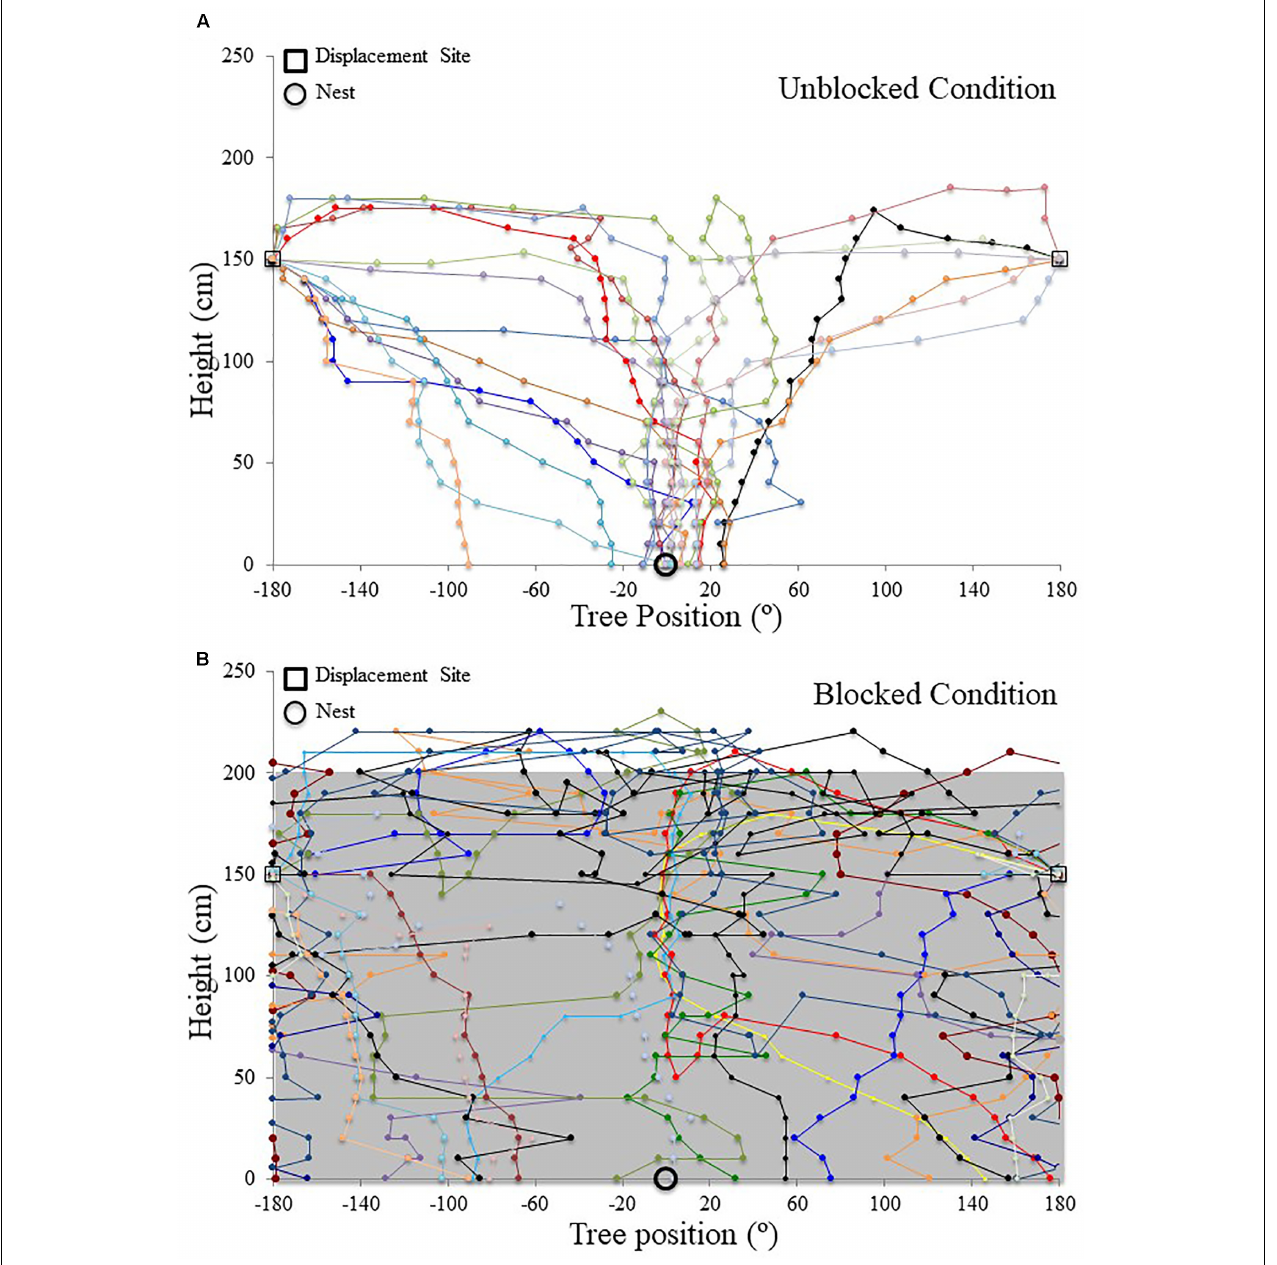
FIGURE 5 | Individual M. midas nest tree foragers’ paths descending the tree face in the landmark blocking experiment. Circular positions on the tree face have been unwrapped to show individuals’ paths from the 180 ◦ off-route, 1.5 m high displacement site (open square) to the ground. The plots are cylindrical, with +180 ◦ and –180 ◦ being the same position on the side of the tree opposite the nest. The open circle at ground level (0 cm) denotes the nest entrance direction. (A) Forager paths in the unblocked condition with the surrounding landmarks visible. (B) Forager paths in the blocked condition with all surrounding landmarks below 2 m blocked using a plastic screen. The grey area in the background signifies the blocking screen surrounding the tree from 0 to 2